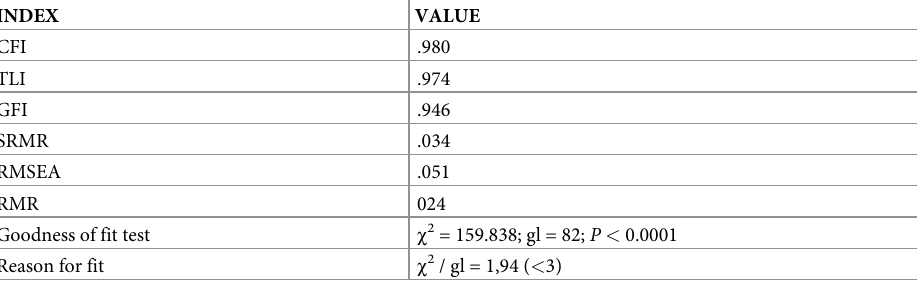
Table 3. Indices of goodness of fit of the confirmatory